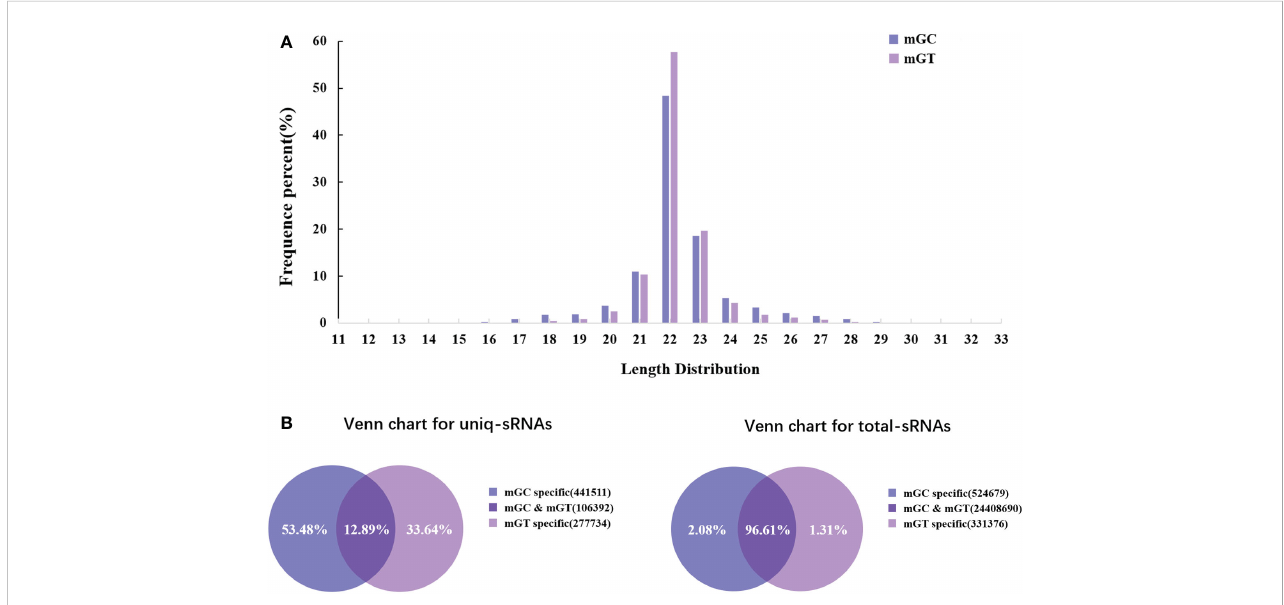
FIGURE 2 Overview of the small RNA (sRNA) sequencing libraries of the gills. (A) Length distribution of the sRNAs from control and infected Carassius auratus . (B) Common and speci fi c sRNA sequences in the two libraries. Unique sRNAs ( left ) and total sRNAs ( right ).